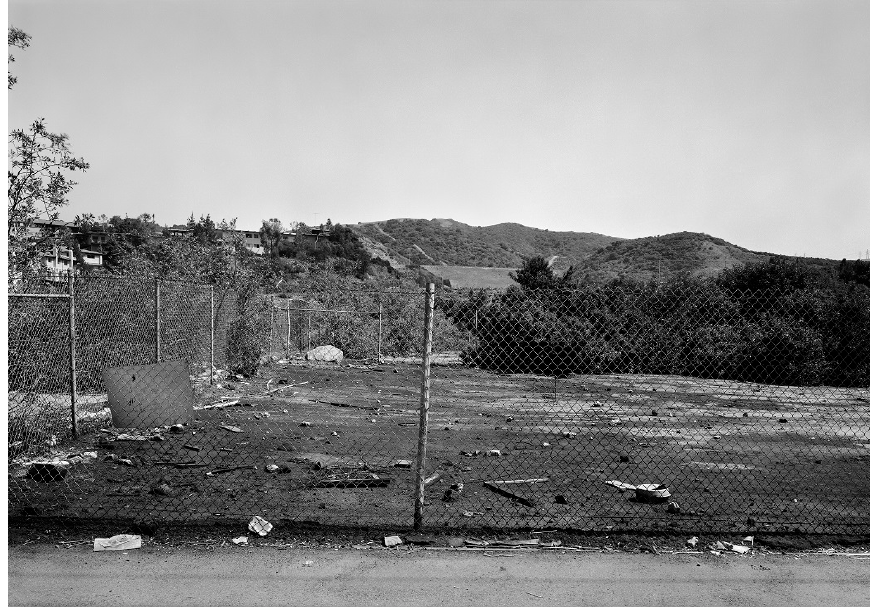
Figure 17. Anthony Hernandez, Automotive Landscapes #42 (1978), © Anthony Hernandez.